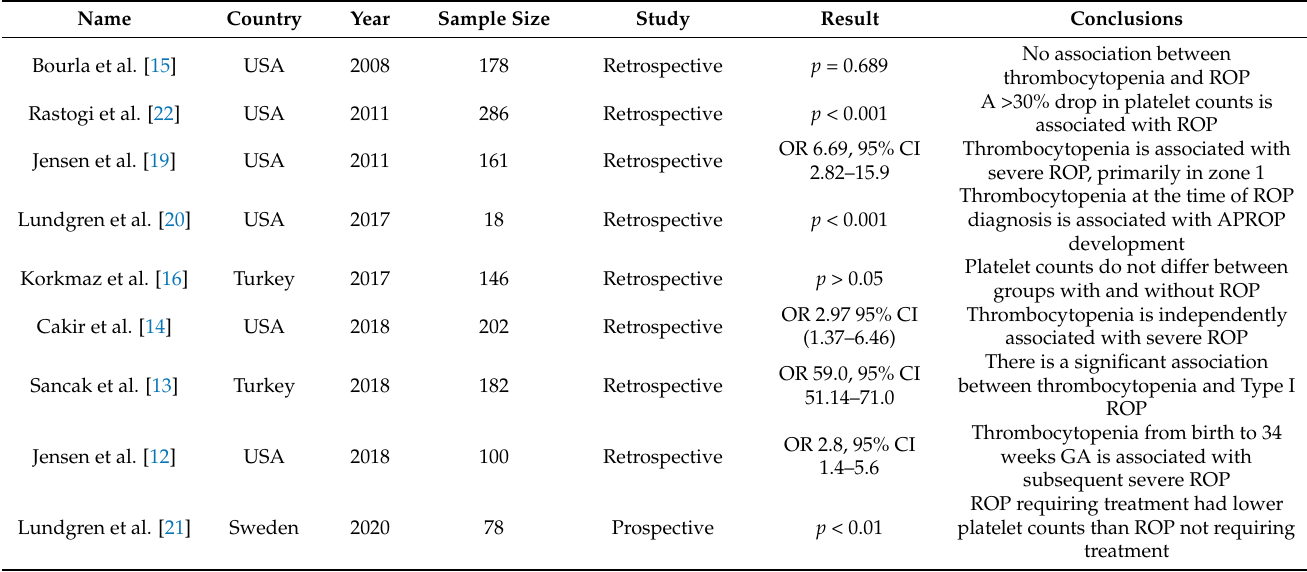
Table 5. Summary of literature regarding platelet counts in